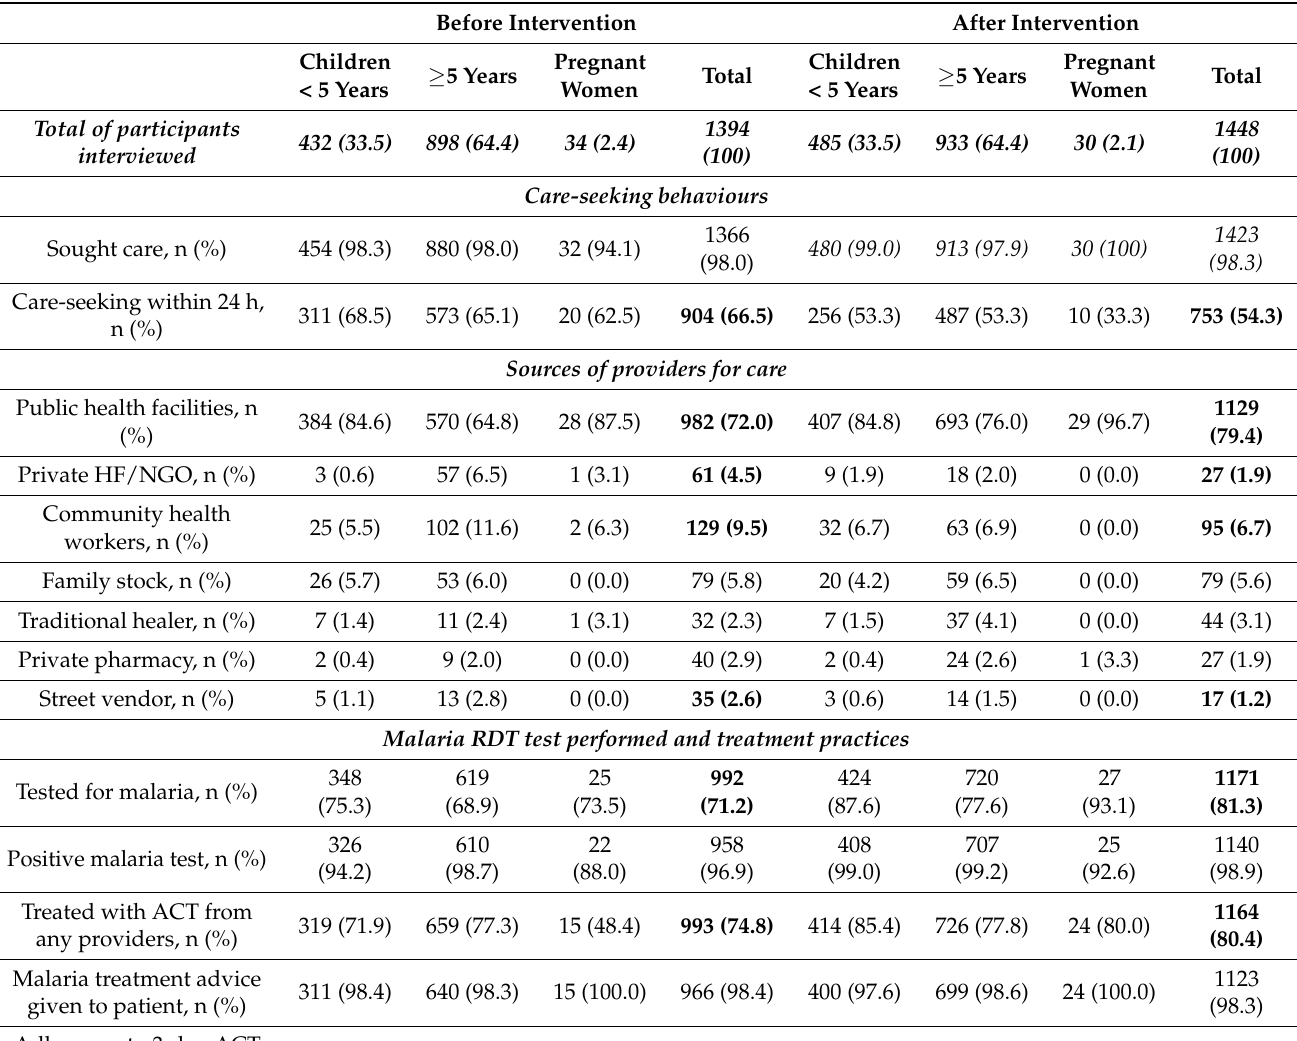
Table 4 outlines the effects of the intervention on health care seeking behaviour. The use of PHF as the first source of care significantly increased from 72.0% (95% CI; 69.6–74.4) at baseline to 79.4% (95% CI; 77.2–81.5) at the end of the study with aOR = 1.6 (95% CI, 1.3–1.9). The care-seeking behaviour for treatment in case of fever was not affected by the intervention ( p = 0.58) conversely to the promptness which significantly decreased from 66.5% at baseline to 54.3% ( p < 0.001). Table 4. Effect of MFT strategy on community care-seeking behaviours and malaria case management. Before Intervention After Intervention Children